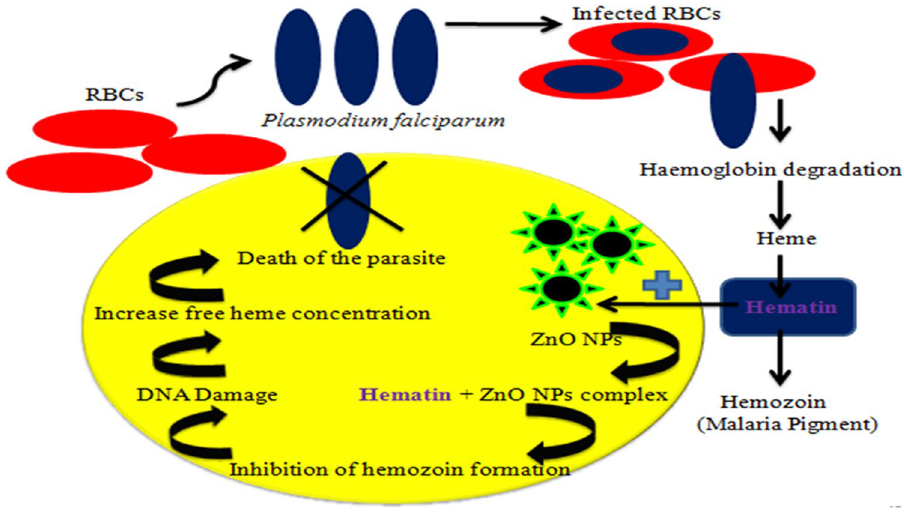
Figure 6. Schematic representation of the mechanism of ZnO NPs on Plasmodium falciparum .